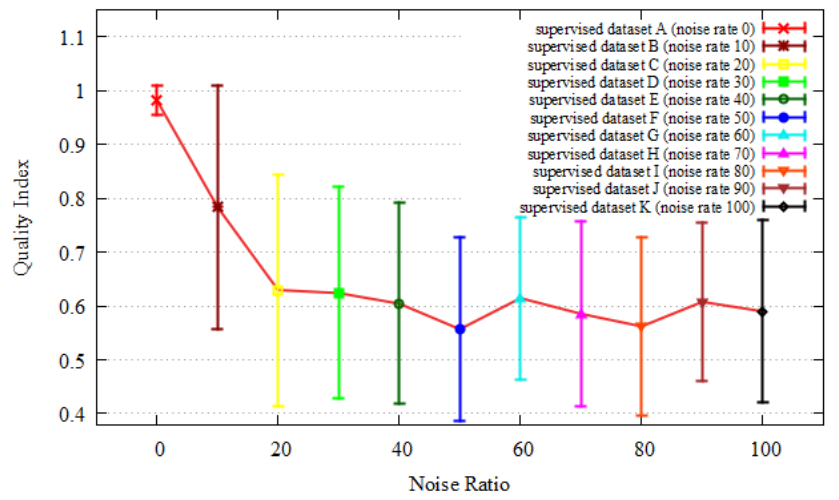
Figure 12. Quality index of each dataset in scenario